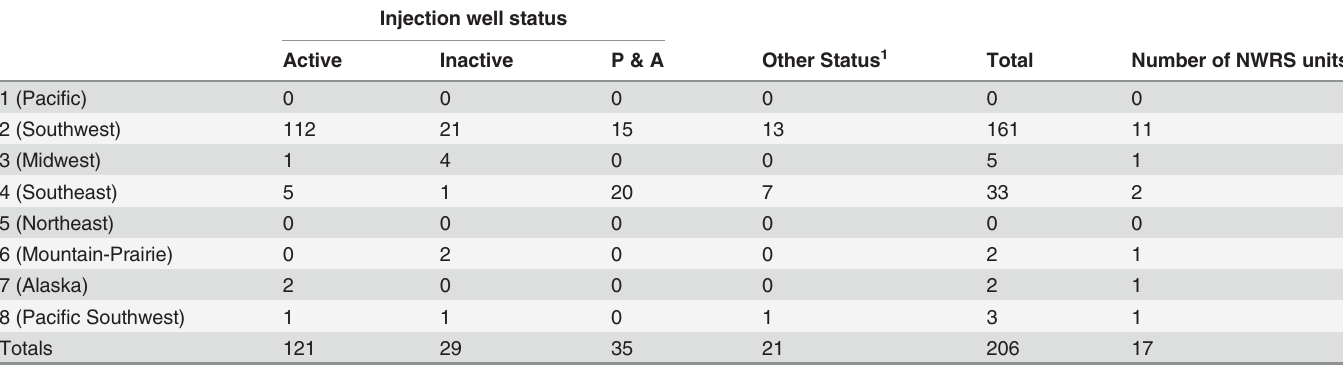
Table 4. Number of injection wells on NWRS units.